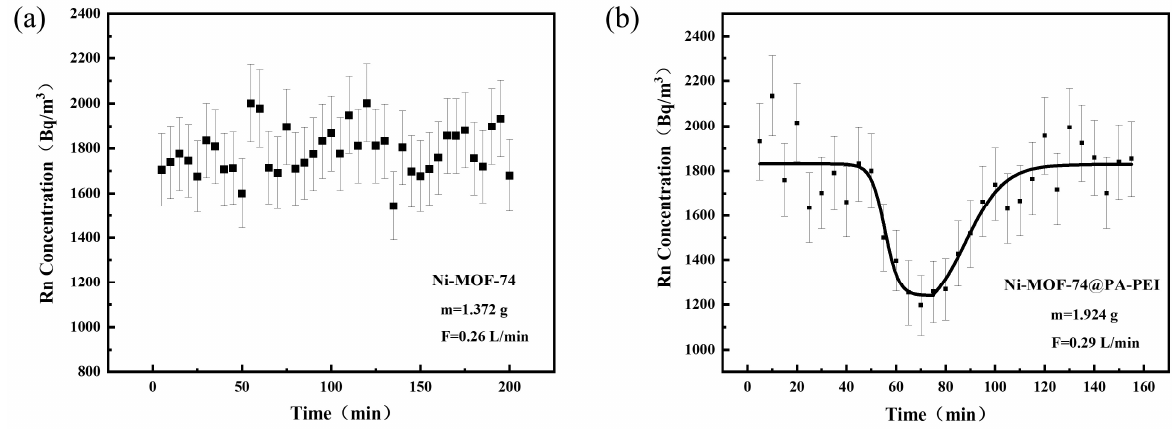
Figure 10. The radon breakthrough curve of ( a ) Ni−MOF−74 and ( b )